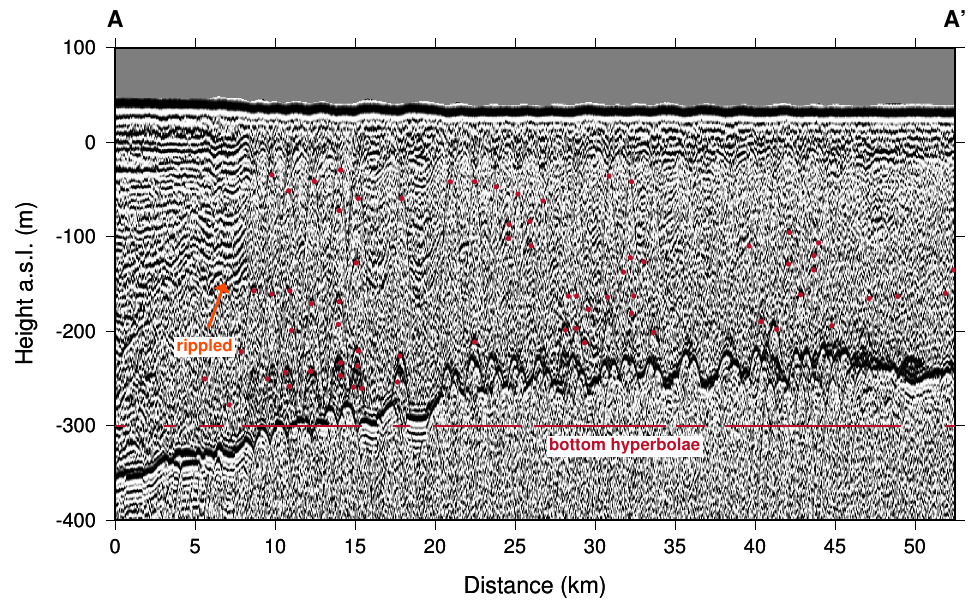
Fig. 3a. Radargram showing a 60 ns profile acquired in 2004 reaching from A to A 0 (locations of are shown in Fig. 2a). The red dots mark the apex of internal hyperbolae and the red line at − 300m denotes the occurrence of bottom hyperbolas. An example for rippled layering in pointed out by the light red arrow at km